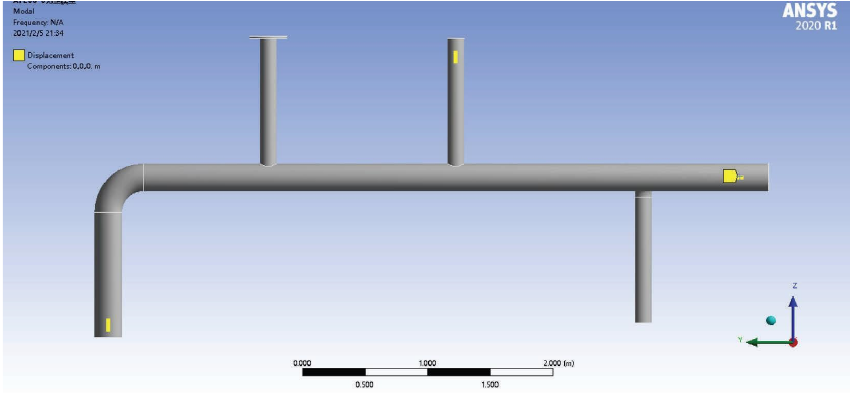
Figure 10: Boundary conditions for the fnite element model of pipeline systems.